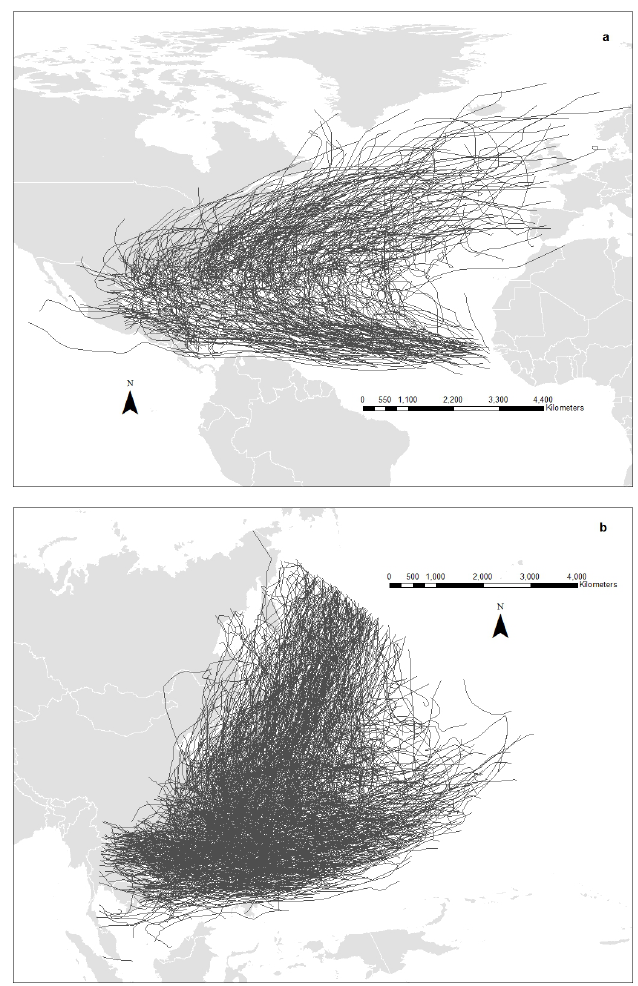
Figure 1. Tropical cyclones (TCs) used in the study in the ( a ) North Atlantic and ( b ) West Pacific